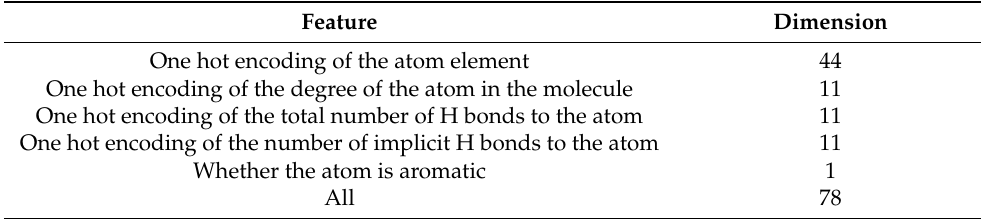
Table 2. Input data representations: Compound atom